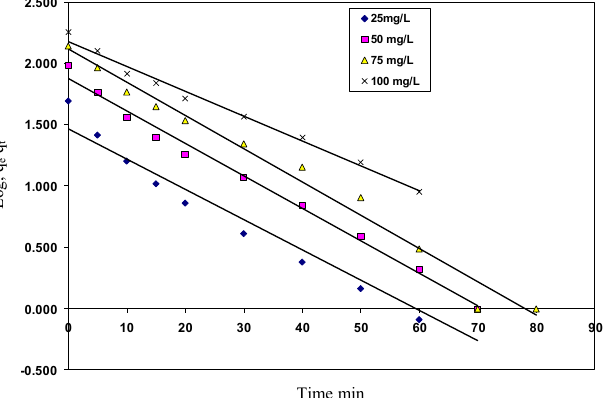
Figure 8. Pseudo first order plot for adsorption AG 25 onto ACC at 303 K.